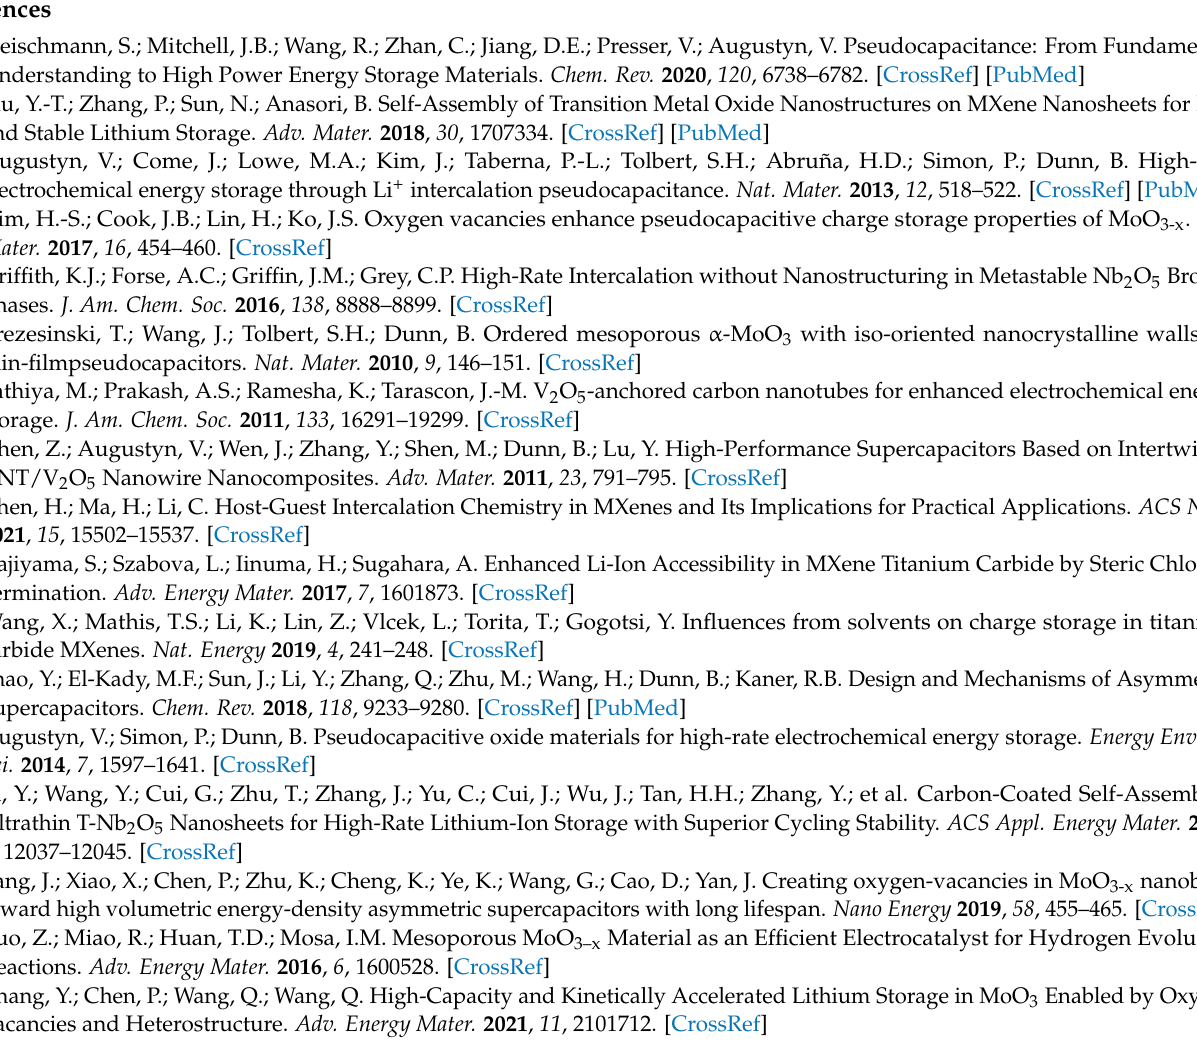
ration process of α -MoO 3 /MXene. Figure S2: XRD diffraction patterns of Ti 3 AlC 2 and Ti 3 C 2. Figure S3: (a) TEM image of Ti3C2; the inset shows the SAED pattern. (b) HR-TEM image of α -MoO α -MoO 3 /MXene; the inset shows the SAED pattern. (c) HAADF image of 3 /MXene. (d) EDS element images of α -MoO 3 /MXene. Figure S4: (a) Cycling performance of α -MoO 3 at 0.5 A g − 1 . (b) GCD curves of α -MoO 3 in different cycles at 0.5 A g − 1 . Figure S5: Rate capability at different cur- rent densities [20,36–41]. Table S1: Comparison of Li + storage performances of our α -MoO 3 /MXene free-standing electrode with other reported Mo-based materials